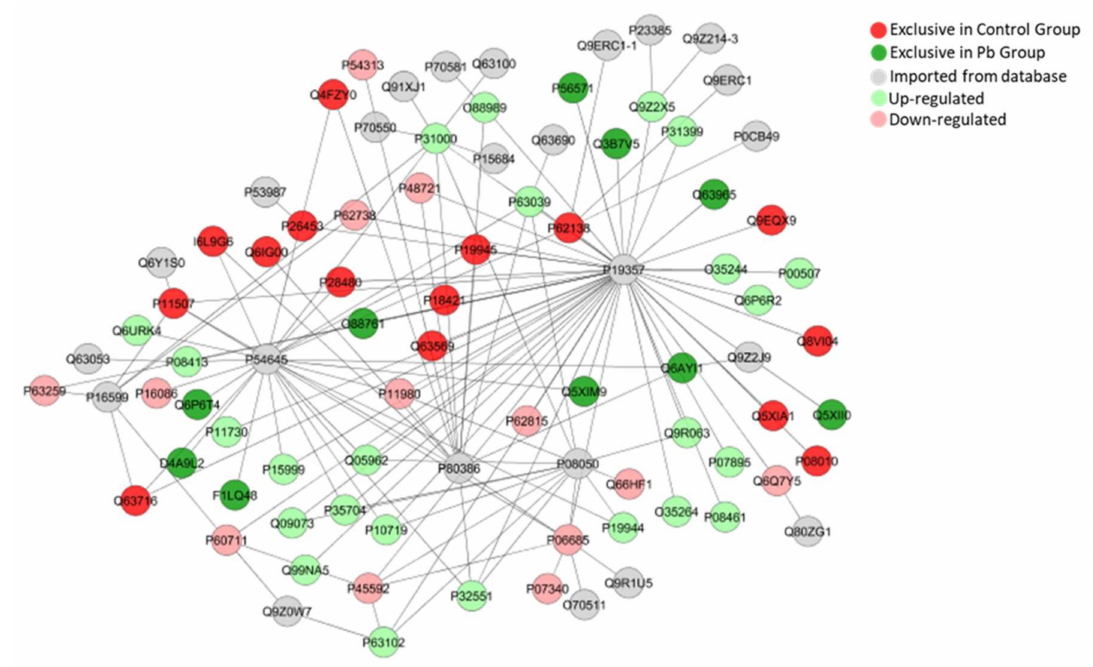
Figure 12. Sub-network created by ClusterMarker app to determine the interaction among identified proteins of the cerebellum with di ff erent expression on exposed group vs. control group, named by its accession ID from Uniprot. Solute carrier family 2, facilitated glucose transporter member 4 (P19357); Sideroflexin-1 (Q63965); Ubiquitin-conjugating enzyme E2 N (Q9EQX9); Peroxiredoxin-6